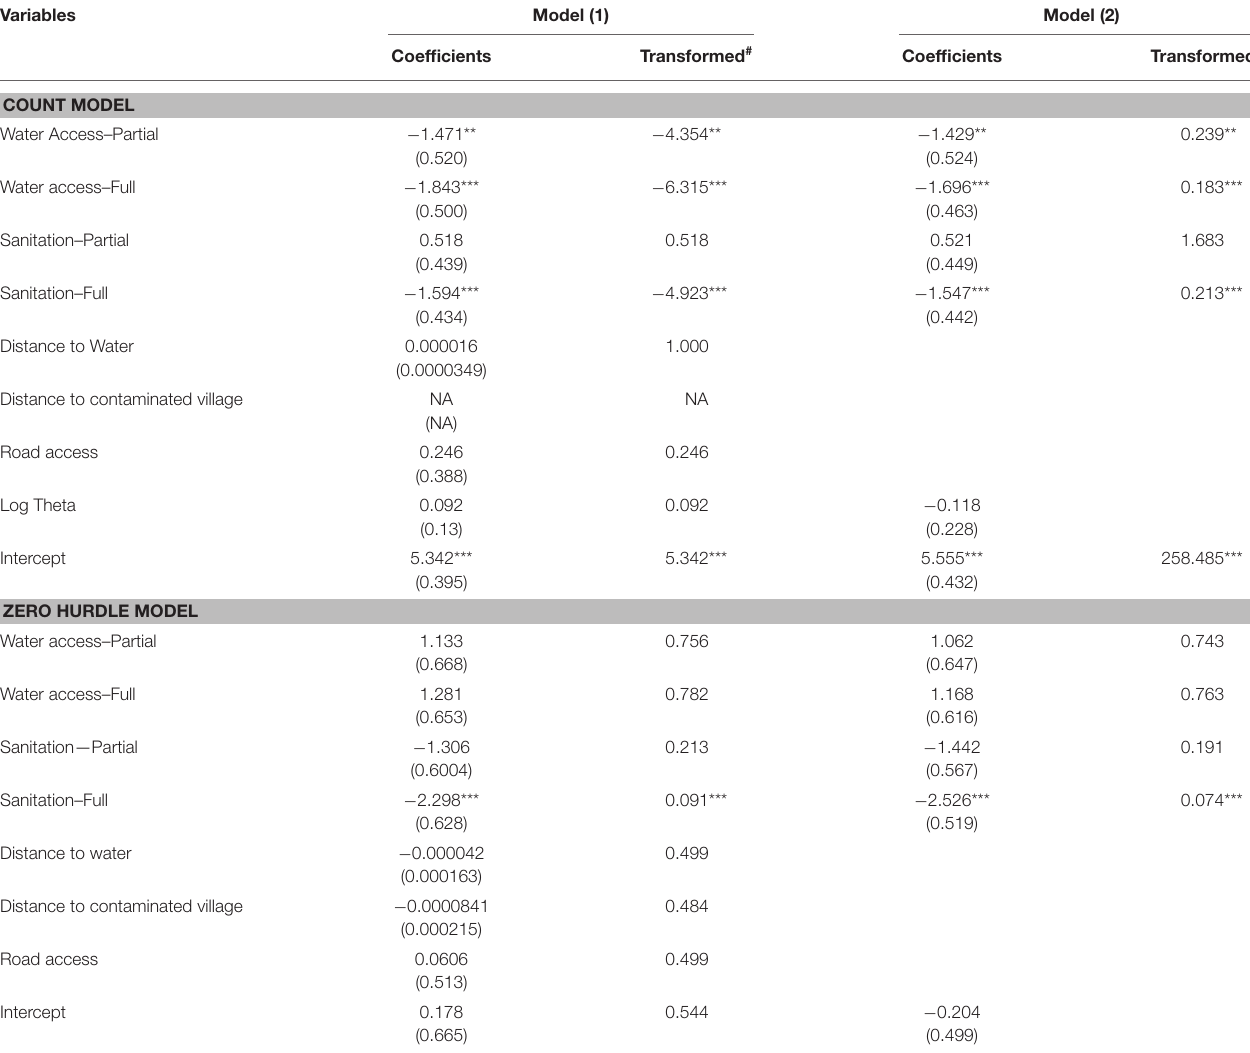
TABLE 3 | Full and partial [Water, Sanitation, and Hygiene (WASH) and non-WASH] hurdle models with village Kabobi.